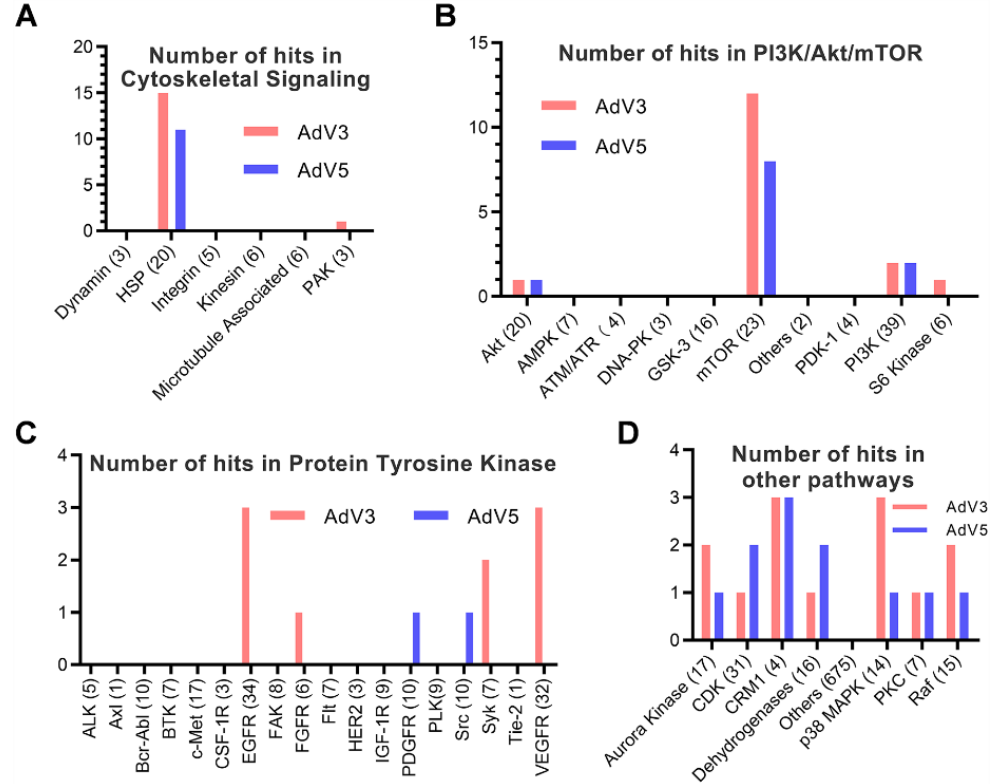
Figure 3. Analysis of the targets of hit compounds from the secondary screen. The target distribution analysis shows that drug targets of all hit compounds in the secondary screen can be categorized into four groups. ( A ) Cytoskeletal signaling. ( B ) PI3K/Akt/mTOR. ( C ) Protein Tyrosine Kinase, and ( D ) other pathways. The total compound number in each category is indicated in parentheses. The number of hits in each category is shown on the Y -axis.